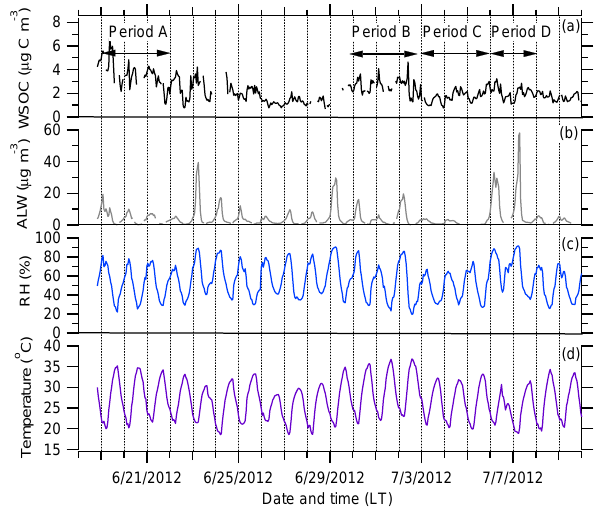
Figure 3. Time series of hourly averaged measured (a) WSOC, (b) calculated ALW, (c) RH, and (d) temperature at SPC. Any gaps in ALW are due to missing PILS-IC data. The dashed vertical lines indicate midnight local time (UTC + 2). Periods A, B, C, and D are also indicated. Fig. 2, Period A occurred during the end of a stagnation.